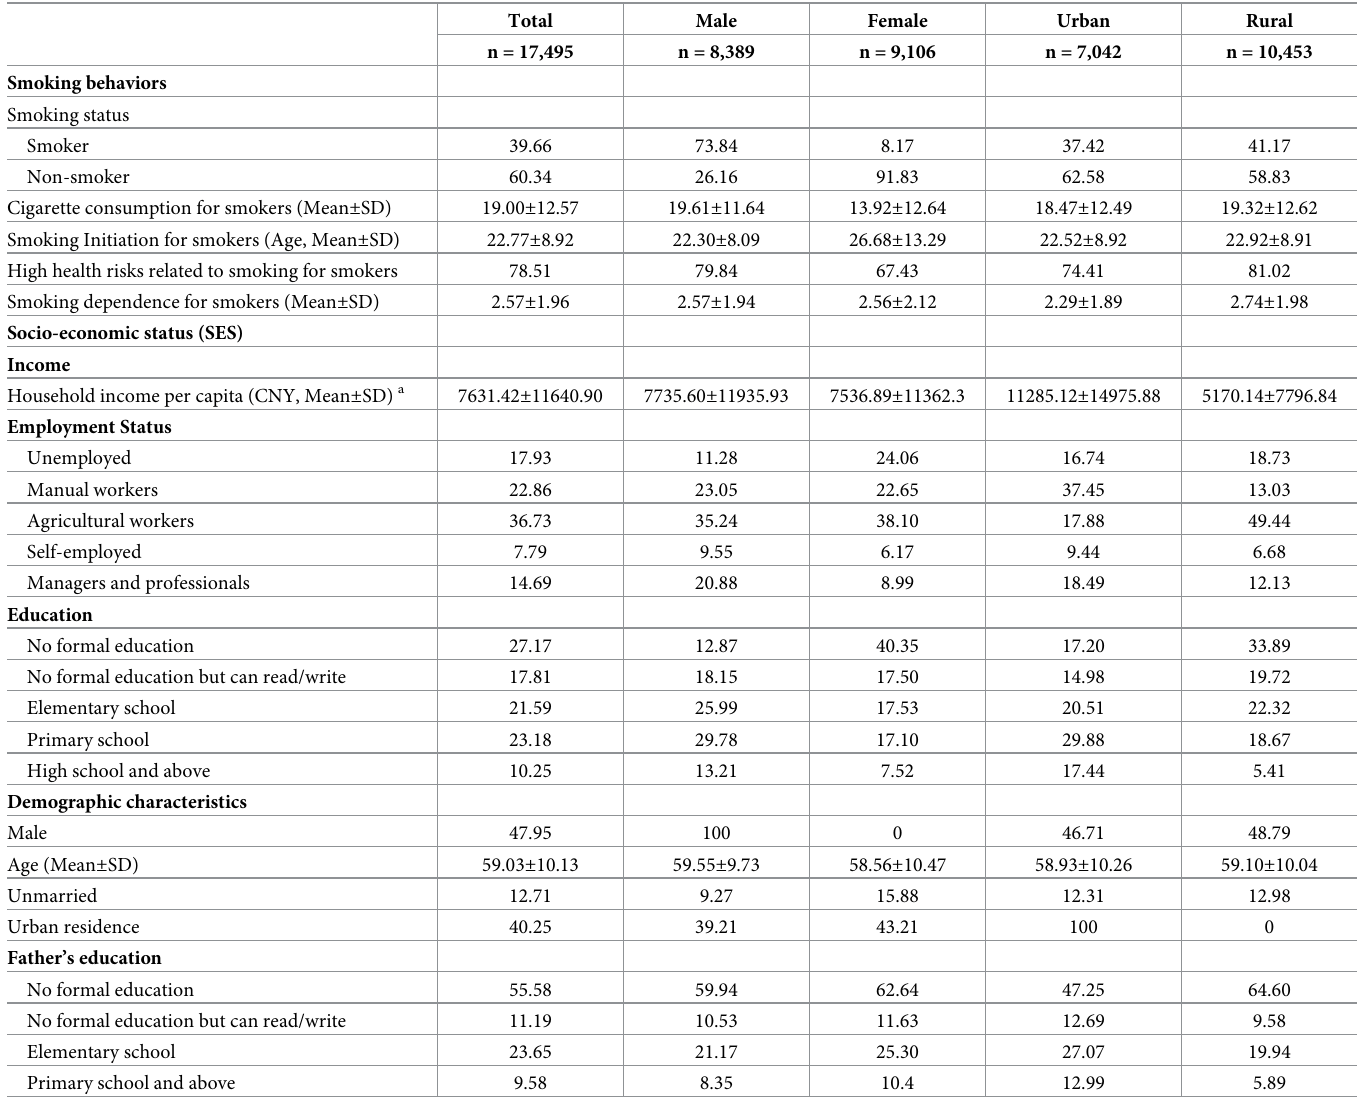
Table 1. Characteristics of the survey respondents, CHARLS 2013